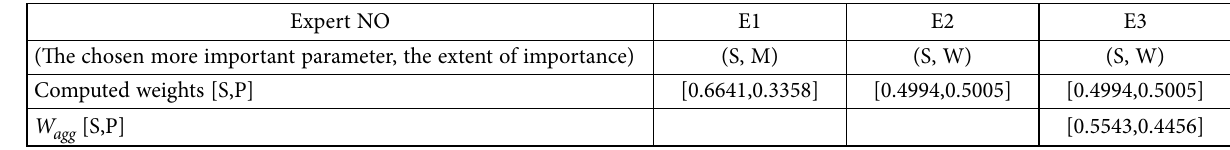
Table 4. Comparisons of the importance of two risk parameters